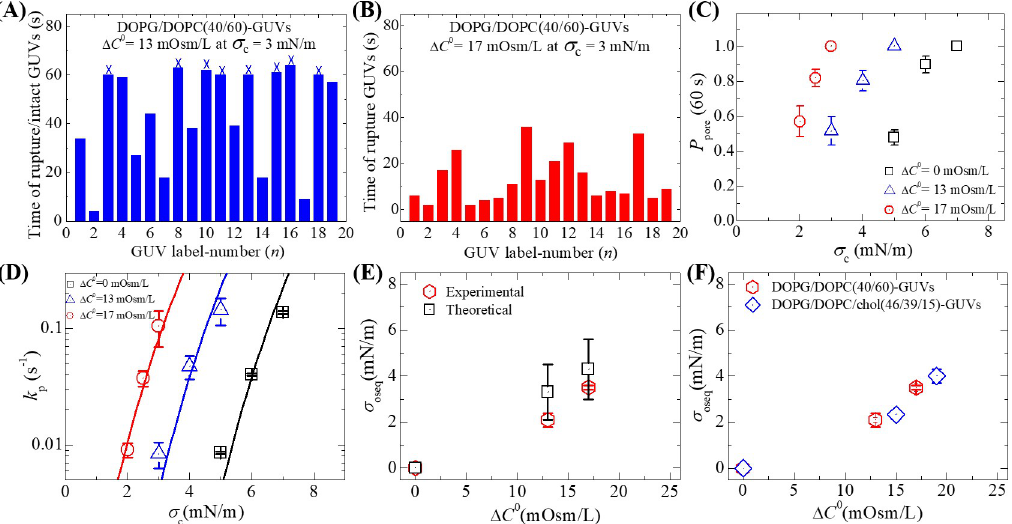
Fig 4. The time of stochastic rupture of several ‘single DOPG/DOPC (40/60)-GUVs’. (A) The osmolarity difference between the inside and outside of GUVs, Δ C 0 = 13 mOsm/L (B) Δ C 0 = 17 mOsm/L at σ c = 3.0 mN/m. The number of measured GUVs in A and B was 19. The bars in A, B represent ruptured and intact GUVs. The cross mark ( × ) above the bars in A indicates the intact GUVs until time 60 s. (C) The σ c dependent P pore (60 s) value for DOPG/DOPC (40/60)-GUVs under Δ C 0 = 0 (black open square), Δ C 0 = 13 mOsm/L (blue open triangle) and Δ C 0 = 17 mOsm/L (red open circle). (D) The σ c dependent k p value for DOPG/DOPC (40/60)-GUVs under Δ C 0 = 0 (black open square), Δ C 0 = 13 mOsm/L (blue open triangle) and Δ C 0 = 17 mOsm/L (red open circle). Average values with standard deviations of k p at σ c were determined for 2–3 independent experiments, each with 15–24 GUVs, for each value of σ c . The solid (black, blue and red) lines were the best-fitted theoretical curves corresponding to Eq (3) using line tension Γ = 12.1 pN, B = 1.76 mN/m and A F = 8.8 × 10 6 m 2 s − 1 J − 1 . The blue line and the red line correspond to the theoretical Eq (3) using σ t = σ c + 2.1 mN/m and σ t = σ c + 3.5 mN/m, respectively. (E) The Δ C 0 dependent membrane tensions ( σ oseq ) (experimental and theoretical) at swelling equilibrium. Experimental values are determined by analyzing the constant electric tension-induced rupture of GUVs. Their mean values with standard deviations are shown. (F) Comparison of experimentally determined membrane tension for DOPG/DOPC (40/60) and DOPG/DOPC/ chol (46/39/15)-GUVs under different Δ C 0 .